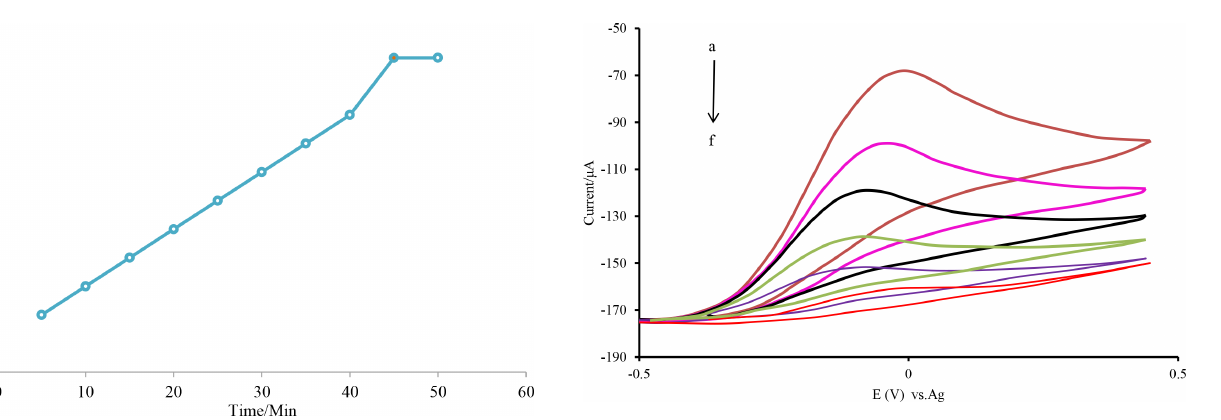
Figure 5. Cyclic voltammograms of hybridized pssDNA with various concentrations of Aeromonas hydrophila tssDNA (1.0 × 10 − 4 molL − 1 (curve a), 1.0 × 10 − 5 molL − 1 (curve b),